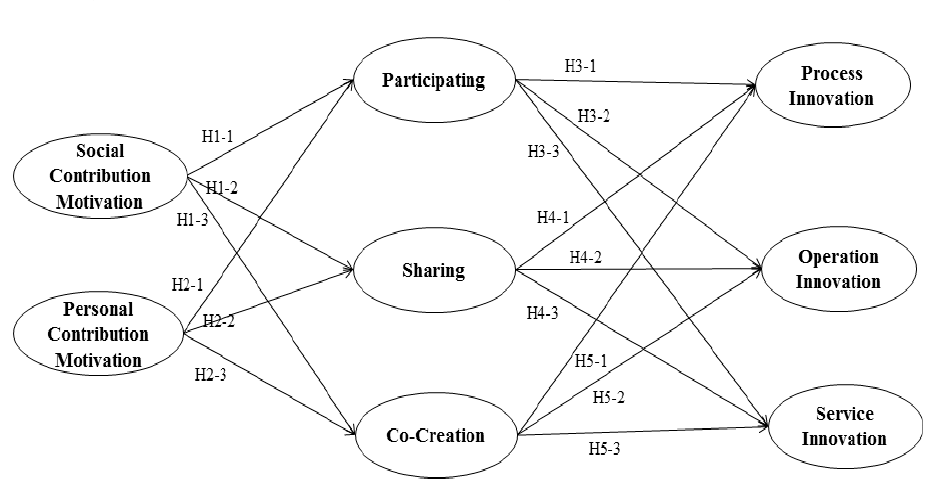
Figure 1. Suggested research model.